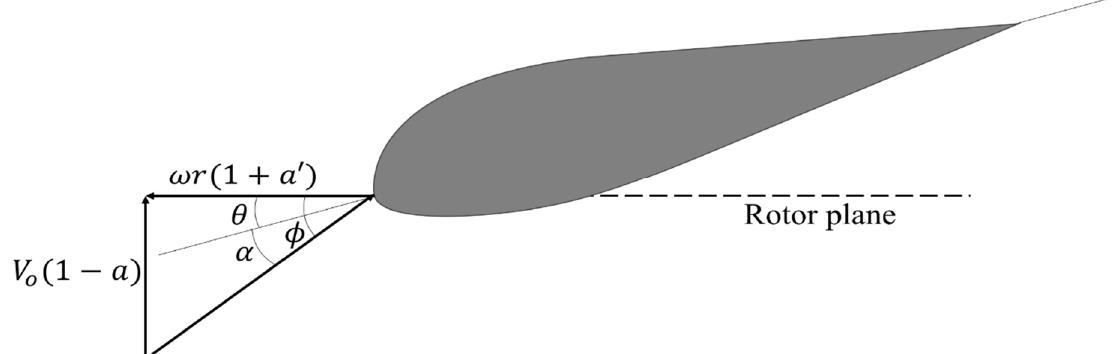
Figure 1. Direction of velocities at an annular element. Reproduced with permission from [R I Syifa], [2nd international Tropical Renewable Energy Conference (i-TREC) 2017]; published by [IOP Conf. Series: Earth and Environmental Science 105 (2018) 012102], [2018], [5].